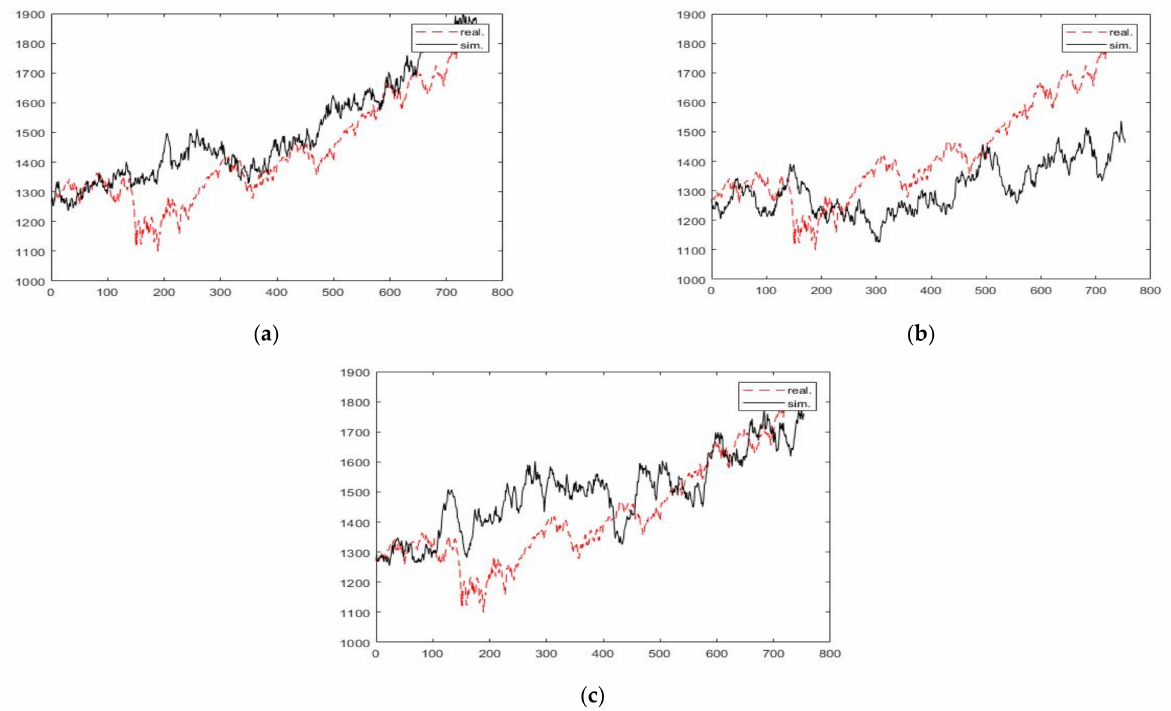
Figure 1. Simulation results using GFBM (3-year period): ( a ) Hurst PE, ( b ) Hurst RS, ( c ) Hurst